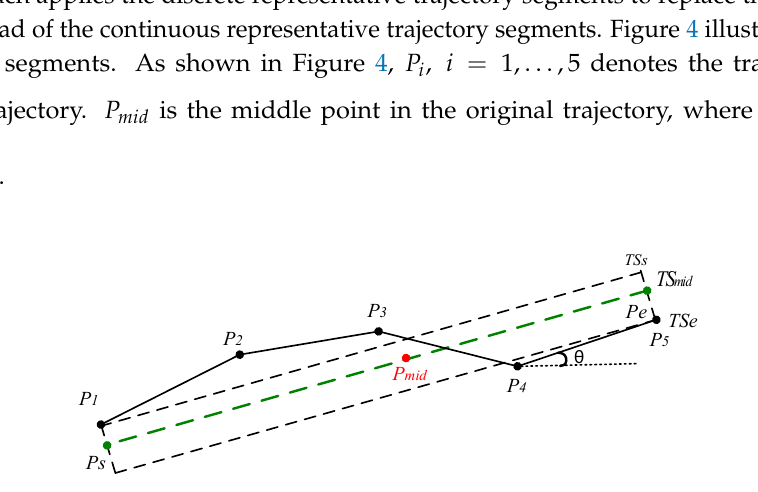
Figure 4. The diagram of the discrete representative trajectory segment.